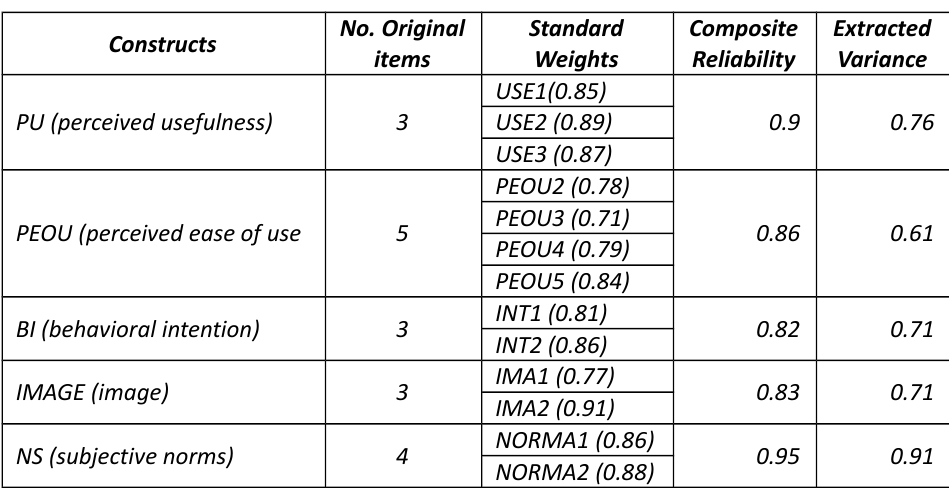
Table 5. Values for the proposed structural